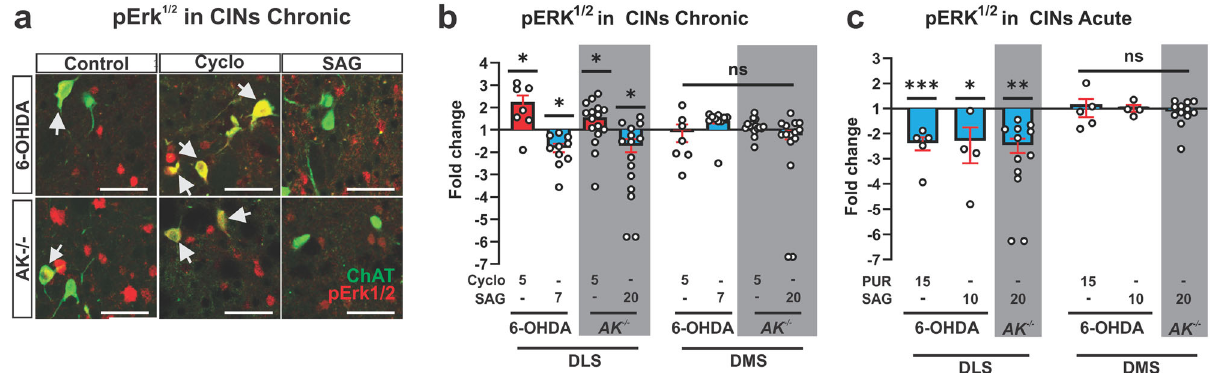
Fig. 2 Smo activity modulates the MAP Kinase pathway in CIN. a Representative images from DLS of 6-OHDA or AK − / − mice showing co-localization (white arrows) of the cytohistological LID marker pErk 1/2 (red) with the CIN marker ChAT (green). Images were taken from DLS of animals whose AIMs were quanti fi ed in b and c of Fig. 1 and that underwent repeated co-administration of L-Dopa (5 mg/kg for 6-OHDA or 25 mg/kg for AK − / − animals) with vehicle (control), cyclopamine (5 mg/kg), or SAG (7 mg/kg for 6-OHDA mice or 20 mg/kg for AK − / − mice). Scale bar = 50 µ m. b Quanti fi cation of the prevalence of pErk 1/2 -positive CIN expressed as fold change over vehicle in the DLS and DMS. cyclopamine treatment increased pErk 1/2 prevalence and SAG treatment decreased pErk 1/2 prevalence in the DLS with no changes in the DMS ( n = 7 – 15 per condition; three sections each; ~36 CIN per section, postmortem analysis of animals quanti fi ed in Fig. 1b, c; unpaired two-tailed Student ’ s t test: * p < 0.05 treatment vs. vehicle. n.s. indicates p > 0.05). c Quanti fi cation of the prevalence of pErk 1/2 -positive CIN in L-Dopa treated 6-OHDA (5 mg/kg L-Dopa for 14 days) or AK − / − (25 mg/kg L-Dopa for 20 days) animals given a single dose of PUR (15 mg/kg) or SAG (10 mg/kg for 6-OHDA animals, 20 mg/kg for AK − / − animals). Results are expressed as fold change in pErk 1/2 exspression over vehicle controls in the DLS and DMS. Smo agonist treatment signi fi cantly reduced the prevalence of pErk 1/2 - positive CIN in the DLS but not in the DMS ( n = 5 – 13 per condition; three sections each; ~36 CIN per section, postmortem analysis of animals whose AIMs were quanti fi ed in Fig. 1d, e; unpaired two-tailed Student ’ s t test: * p < 0.01, *** p < 0.001, for treatment vs. vehicle. n.s. indicates p > 0.05). All bar graphs are plotted as mean ±